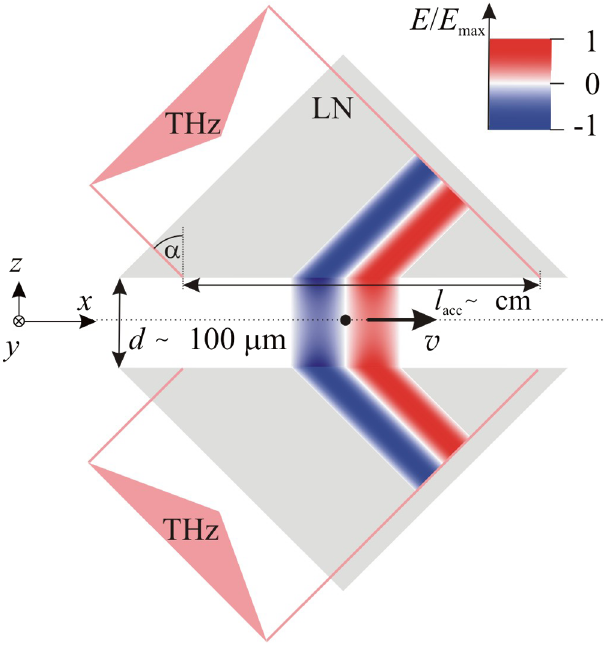
FIG. 1. Scheme of the THz-driven evanescent-wave